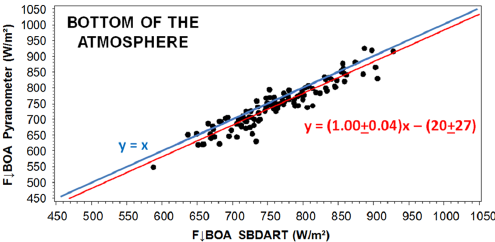
Figure 7. Intercomparison between the incoming flux in Wm − 2 at the bottom of the atmosphere (BOA) measured by SolRad-NET pyranometers and modelled using AERONET and MODIS BRDF retrieved optical properties as inputs in SBDART.